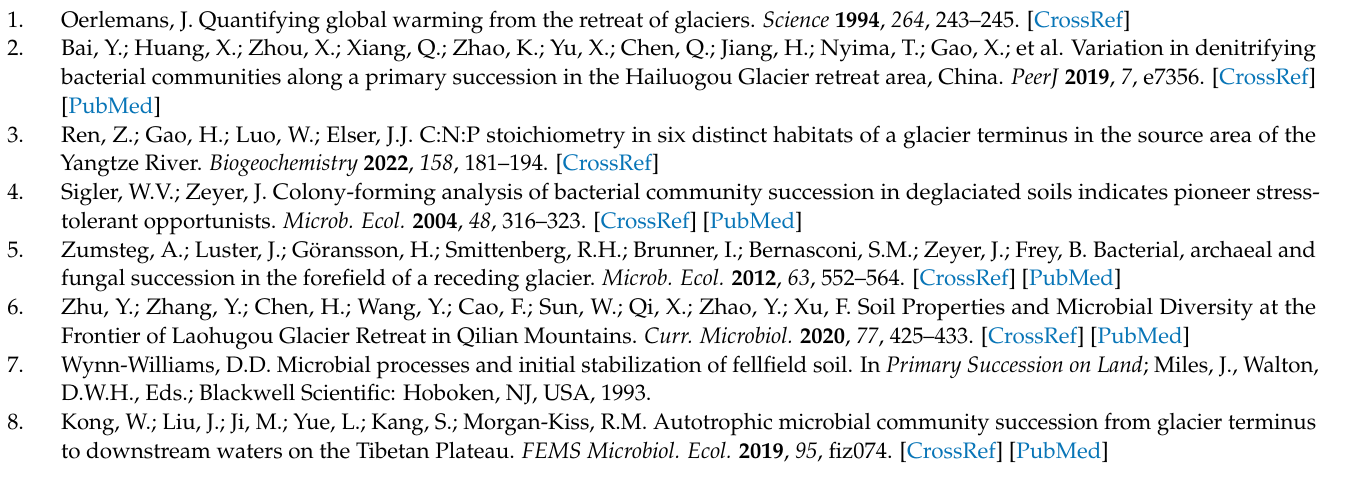
used. Venn diagram comparing the genera isolated in R2A, PYGV, TSB, and TSB 0.1x media at HT ( a ) and LT ( b ). Figure S2. The percentage ( a ) and abundance ( b ) of the culturable new species at HT and LT. Frequency of total possible new species and known species comparing the genera isolated in R2A, PYGV, TSB, and TSB 0.1x media at HT and LT ( c ), ( d – f ) were the results of different pretreatments with normal, oxidation, and radiation, respectively, under the same conditions as ( c ). Figure S3. Co-occurrence networks of culturable bacterial species associated with environmental factors. Each edge means significant correlations between the nodes. Within the edges, the solid lines and the dashed lines represent positive and negative correlations, respectively, while the blue and red lines refer to Spearman’s correlation at the levels of p < 0.05 and p < 0.01, respectively. Table S1. Media was used for isolation in this study. Table S2. Taxonomic affiliations of strains, determined by phylogenetic analysis of 16S rRNA. Table S3. List of genera represented in the Venn diagram of Figure S1. Table S4. List of genera represented in the Venn diagram of Figure 5a,f. Table S5. List of genera represented in the Venn diagram of Figure